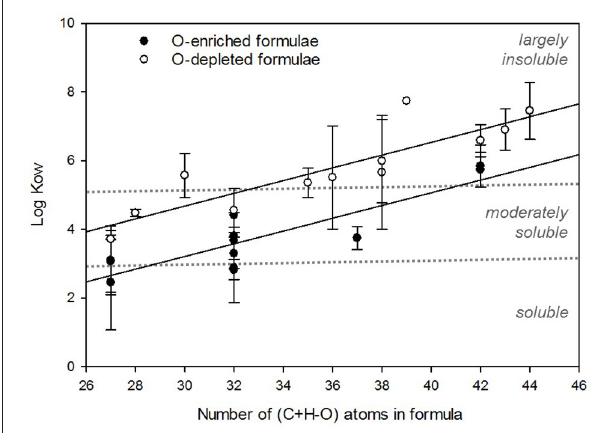
FIGURE 2 | Linear correlations between the log K ow and C + H–O number for 90 proposed DBC structures. Data points were binned according to their C + H–O number. O-depleted formulae (C m H n O x1 ) were used to calculate the high log K ow regression (y = 0.186x – 0.907; R 2 = 0.77) and O-enriched formulae (all C m H n O x2 ) were used to calculate the low log K ow regression (y = 0.185x – 2.350; R 2 = 0.76). Each point represents the binned mean and error bars represent 1